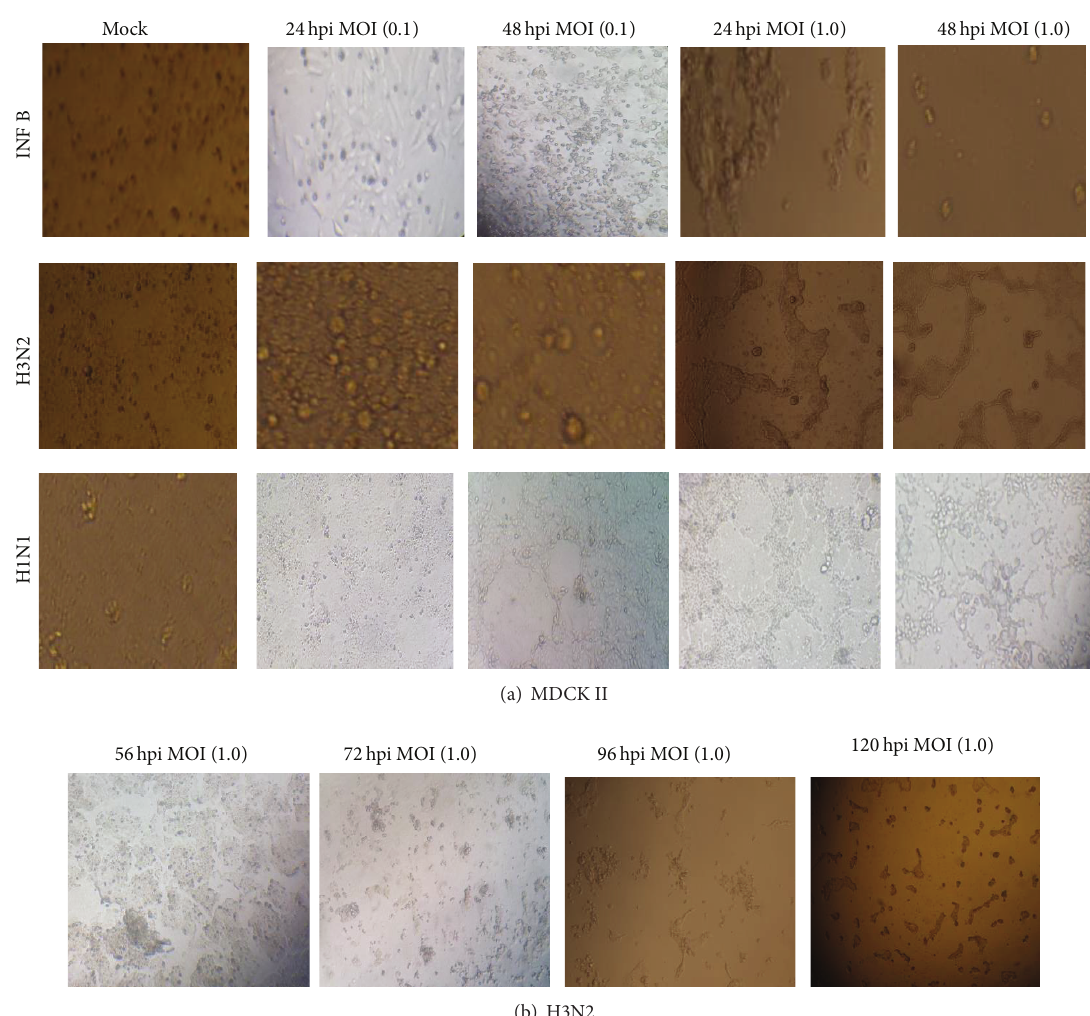
Figure 2: (a) Cytopathogenicity of MDCK II cells to an influenza A and B viruses infection at 24 and 48 hours after infection. (b) The delayed onset of cytopathogenicity by H3N2 (10x